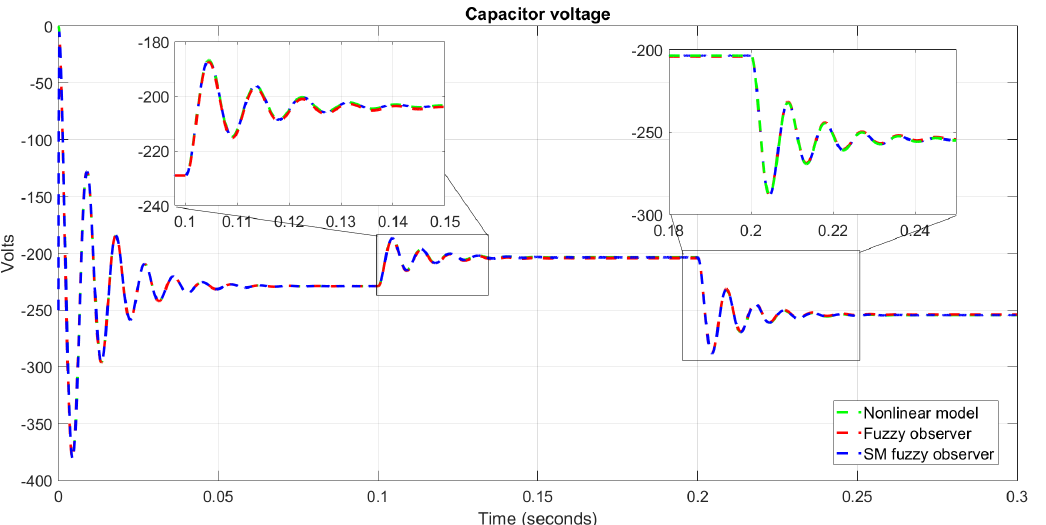
Figure 15. Observer response for the v C voltage with disturbances in the supply voltage V in